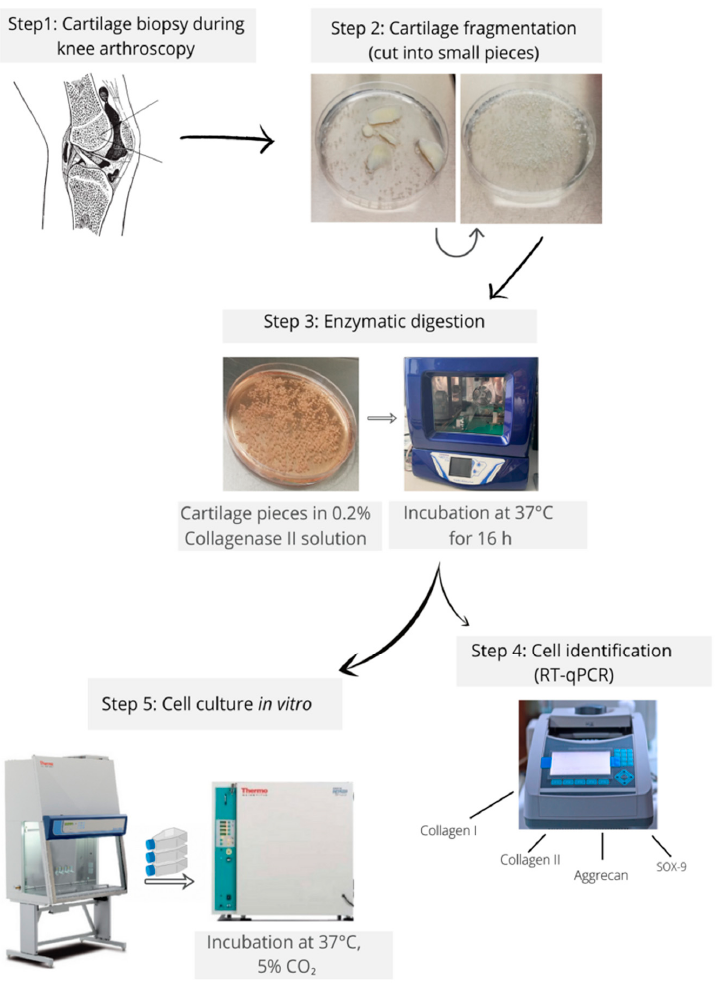
Figure 1. General procedure of isolation and identification of primary human chondrocytes.